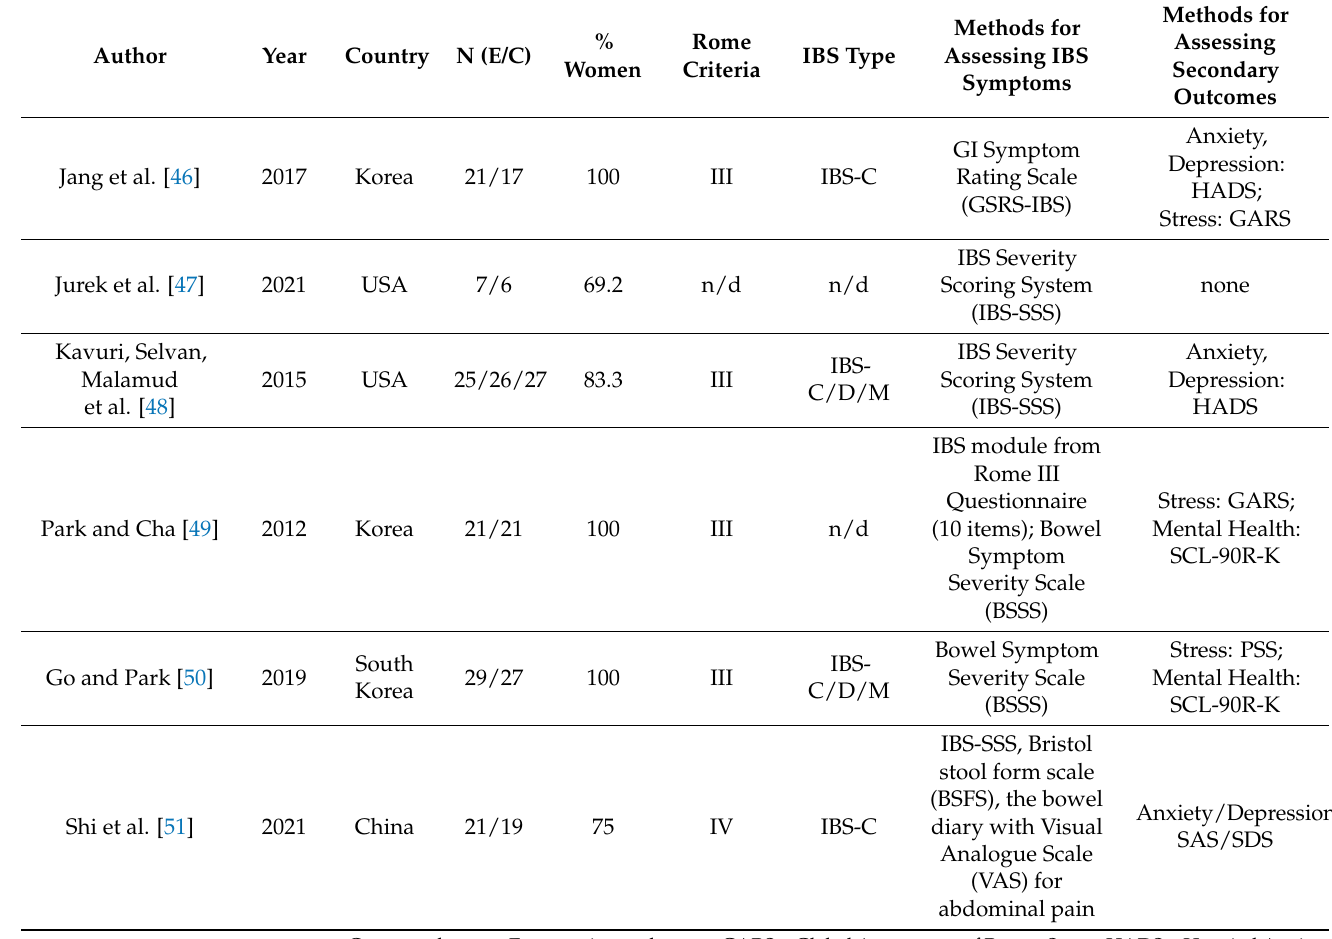
Table 1. General characteristics of research studies included in the review.